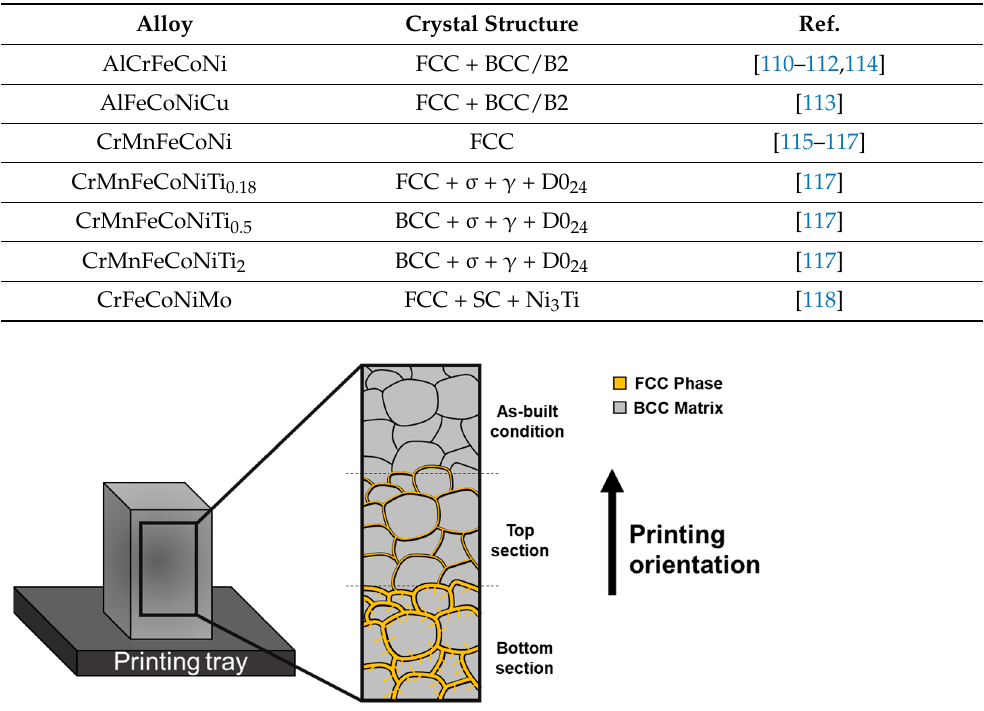
Figure 7. Schematic illustration of the typical microstructure of AlCrFeCoNi and AlFeCoNiCu pro- duced by EB-PBF, showing the formation of FCC phase at grain boundaries due to elemental segre- gation during the pre-heating